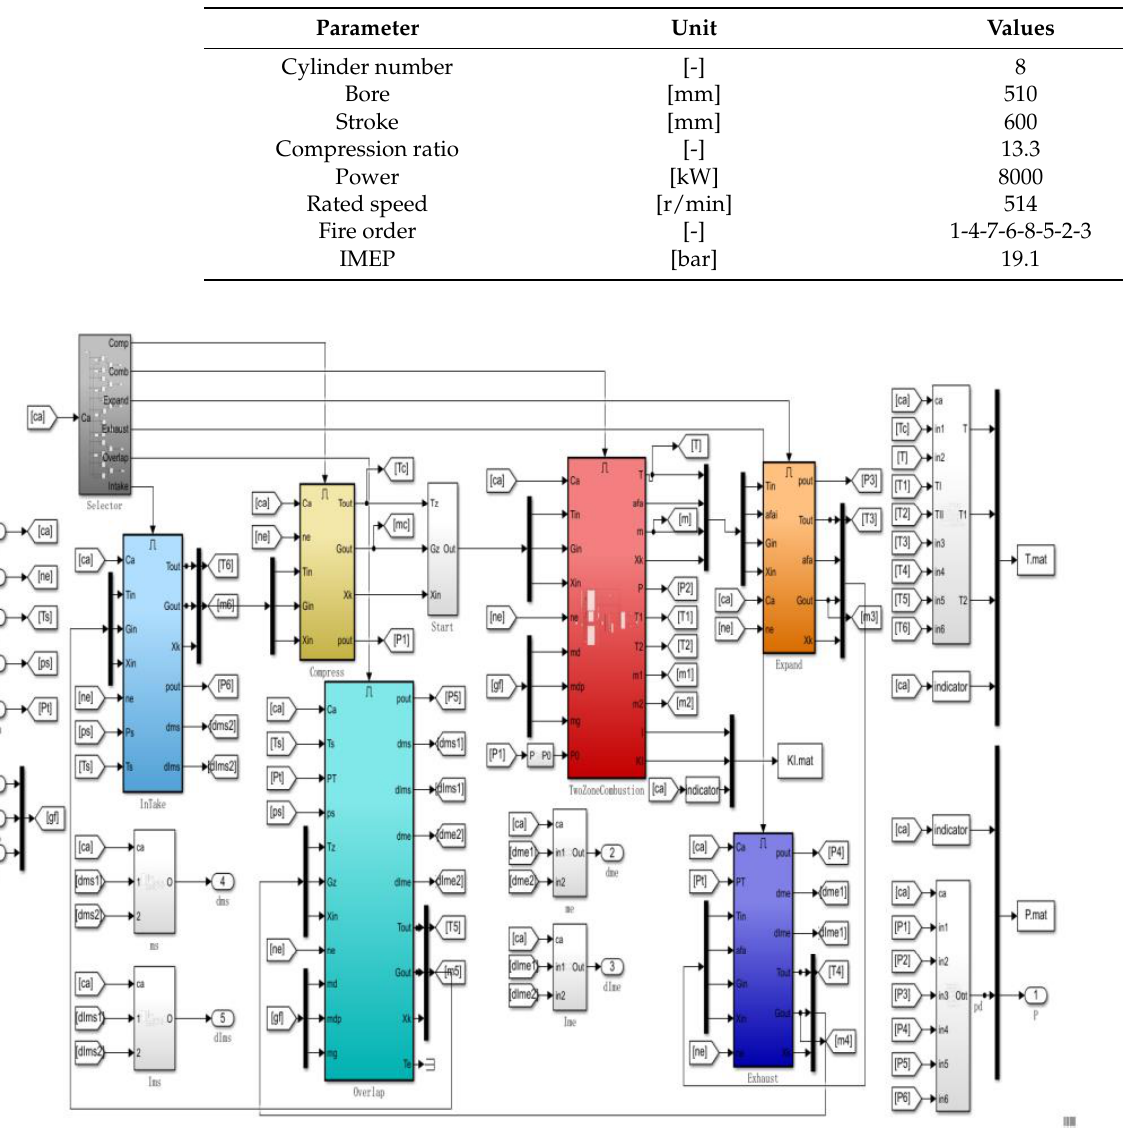
Figure 4. Engine layout and components [9]. Table 2. Engine technical parameters.